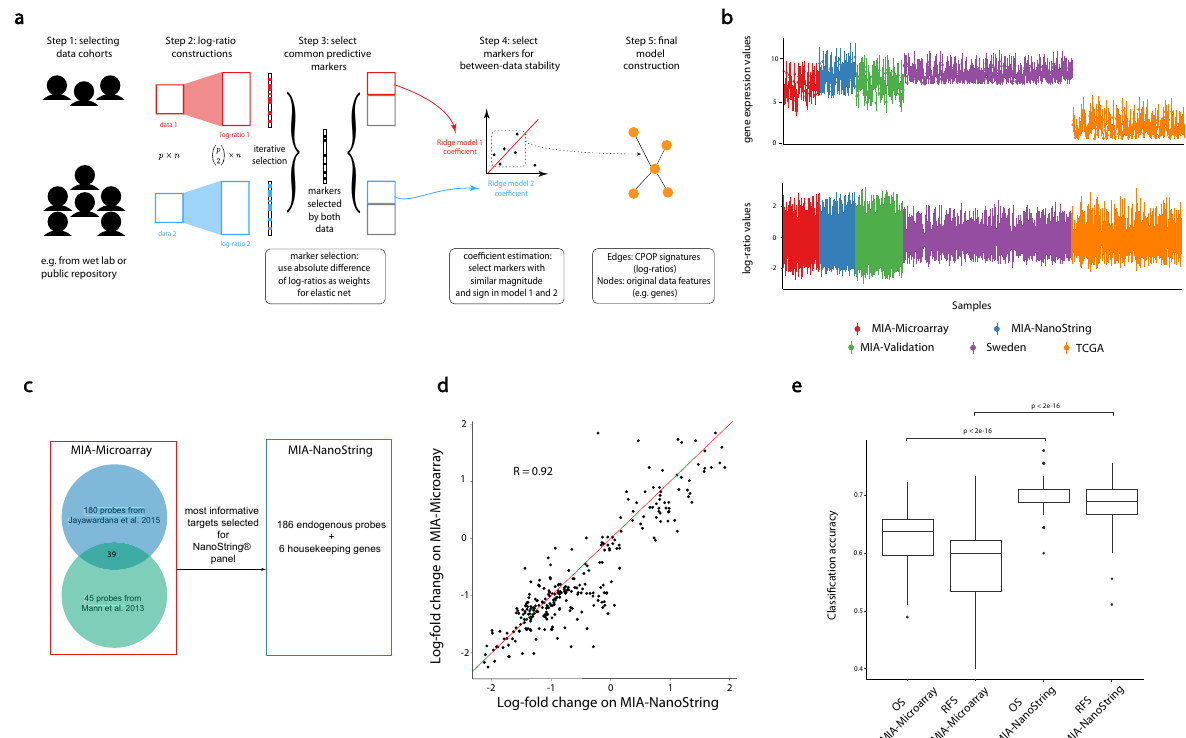
Fig. 1 Overview of CPOP and the motivating melanoma dataset. a Schematic illustration of the fi ve-step CPOP procedure with emphasis on the stable selection of features in Steps 3 and 4. b Quartile plot of the expression values of all genes (top panel) and all pairwise (bottom panel) log-ratio features for each sample ( n = 488) in the melanoma data collection. Each sample is represented by the median (a single solid point), the fi rst quartile (the lower end of a vertical line) and the third quartile (the upper end of a vertical line) of all the gene/feature values for that sample. c NanoString probe selection (186 probes) based on results from our previous microarray studies 7,14 . d Scatter plot of log fold- change for genes common between MIA-Microarray and MIA-NanoString. e Boxplot comparisons of overall accuracy for overall survival (OS) and recurrence-free survival (RFS) between the MIA-Microarray and MIA-NanoString data. The y-axis shows the classi fi cation accuracy calculated from 100 repeated 5-fold cross-validation using a support vector machine classi fi er. The good/poor prognosis classes for overall survival (OS) and recurrence-free survival (RFS) are de fi ned in Methods. The centreline of a boxplot denotes the median classi fi cation accuracy, and the lower and upper bounds of the box denote the fi rst and third quartile values, respectively. The lower and upper whiskers denote 1.5 times the interquartile range away from the fi rst and third quartile values,